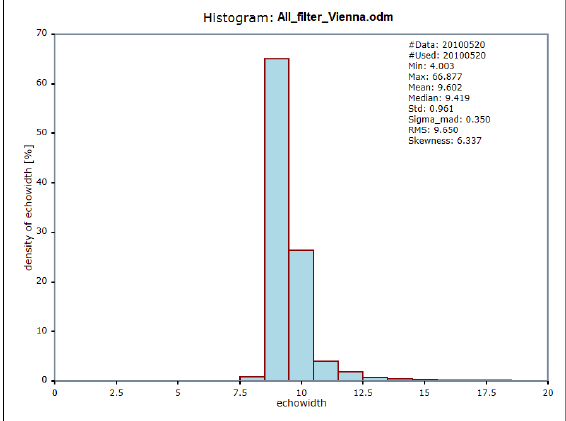
Figure 8. Histogram of echo width value in Vienna region